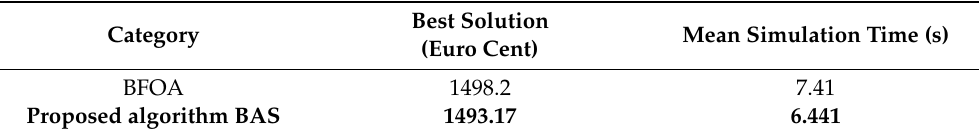
Table 9. Comparison of the cost of generation between BFOA and the proposed BAS algorithm corresponding to Scenario 3.